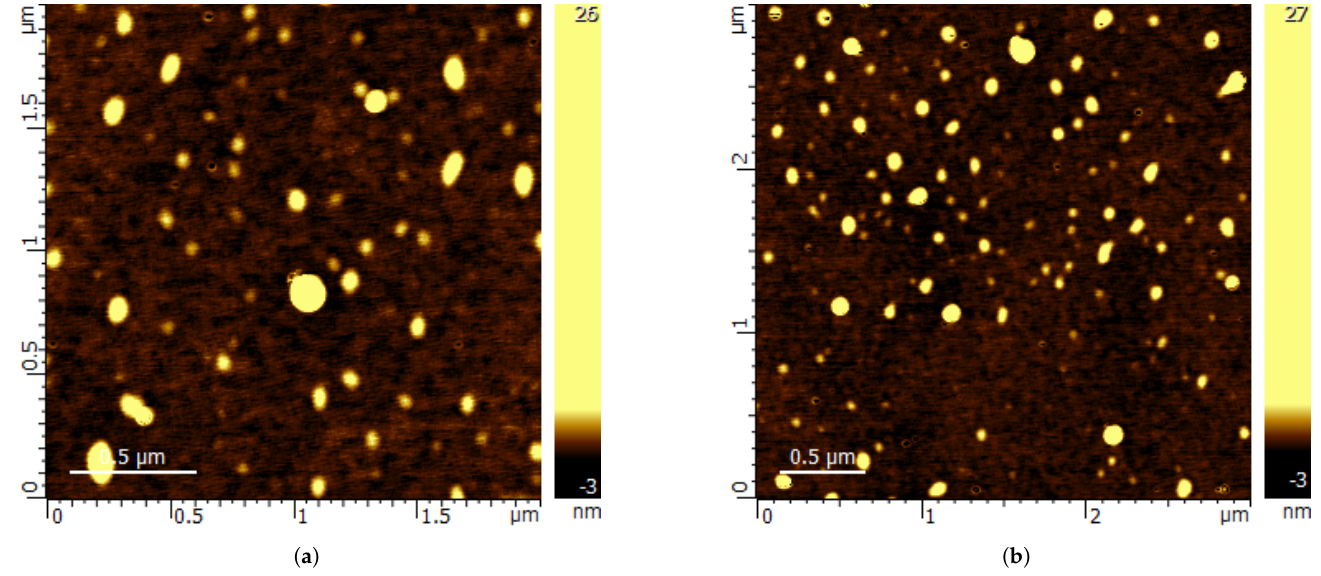
Figure 2. AFM micrographs of St-CTAB ( a ) and St-CTAB-VI ( b